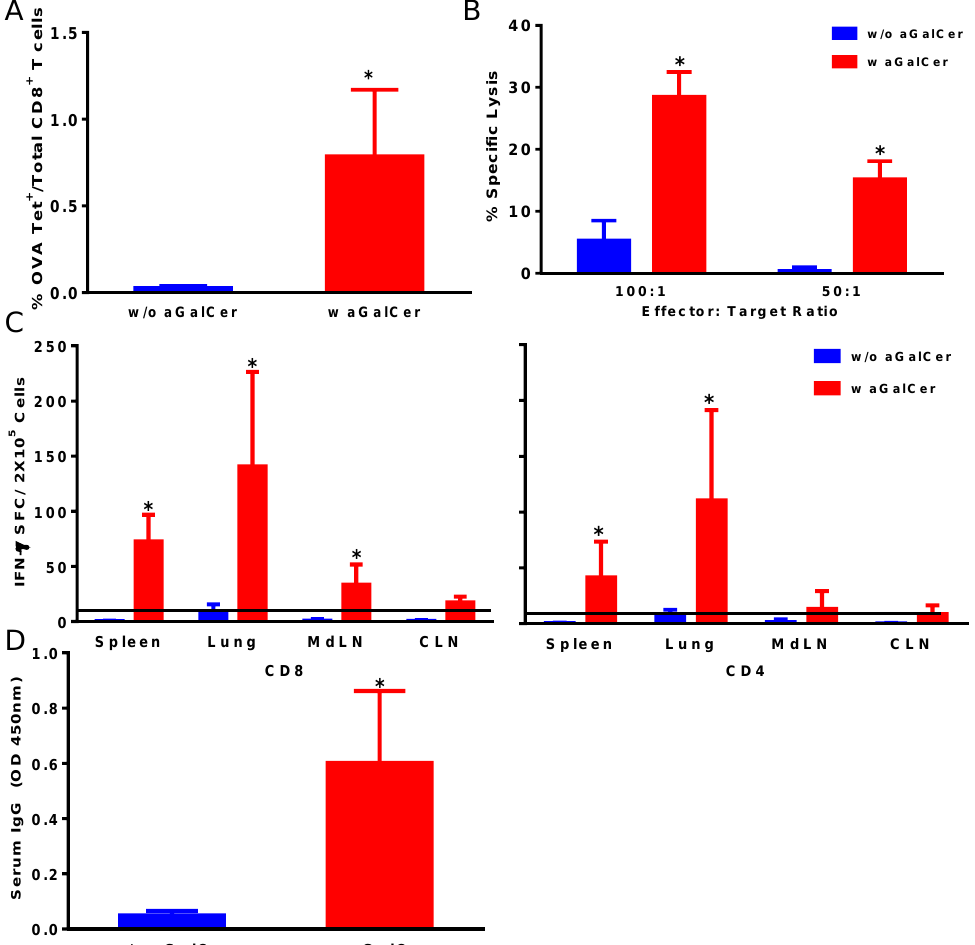
Figure 1. Induction of antigen-specific immune responses by intranasal immunization with vesicular stomatitis viral vector encoding ovalbumin as the model antigen (VSV-OVA) using alpha-galactosylceramide (α-GalCer) adjuvant. Single cell suspensions from spleens were analyzed for the presence of antigen-specific CD8 + T lymphocytes by staining with fluorescently labeled CD8 OVA tetramer and antibodies to mouse CD44 and CD8 along with Aqua live/dead stain ( A ). Antigen-specific cytolytic activity of splenocytes isolated from immunized mice was determined by the standard chromium-release assay employing the syngeneic EL-4 target cells pulsed with the OVA peptide, at two different effector to target cell ratios ( B ). Data were adjusted for background by subtracting control values (target cells not pulsed with the OVA peptide). IFN-γ production in response to stimulation with CD8 and CD4 T cell epitope peptides from OVA was determined by using a standard IFN-γ ELISpot assay ( C ). Data are shown as IFN-γ spot forming cells (SFC) per 2 × 10 5 input cells and OVA specific responses were adjusted to background medium control. Antigen specific IgG antibody responses were determined in serum samples by ELISA ( D ). Data are representative of two separate experiments and expressed as mean ± S.D. Statistical analyses between responses to different immunizations was performed using Mann Whitney Test to determine significant differences ( * p ≤ 0.05) between immunizations with VSV-OVA alone and VSV-OVA admixed with